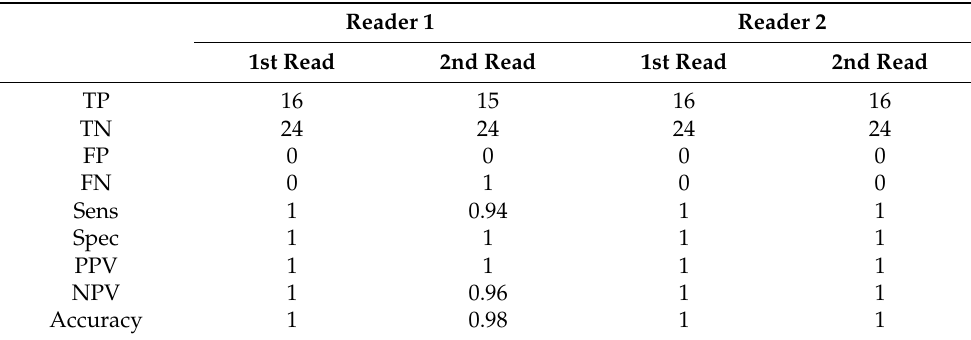
Table 1. The diagnostic performances for the evaluation of the OFR images are shown for each reader. There were no significant differences between the OFR reads and the reference